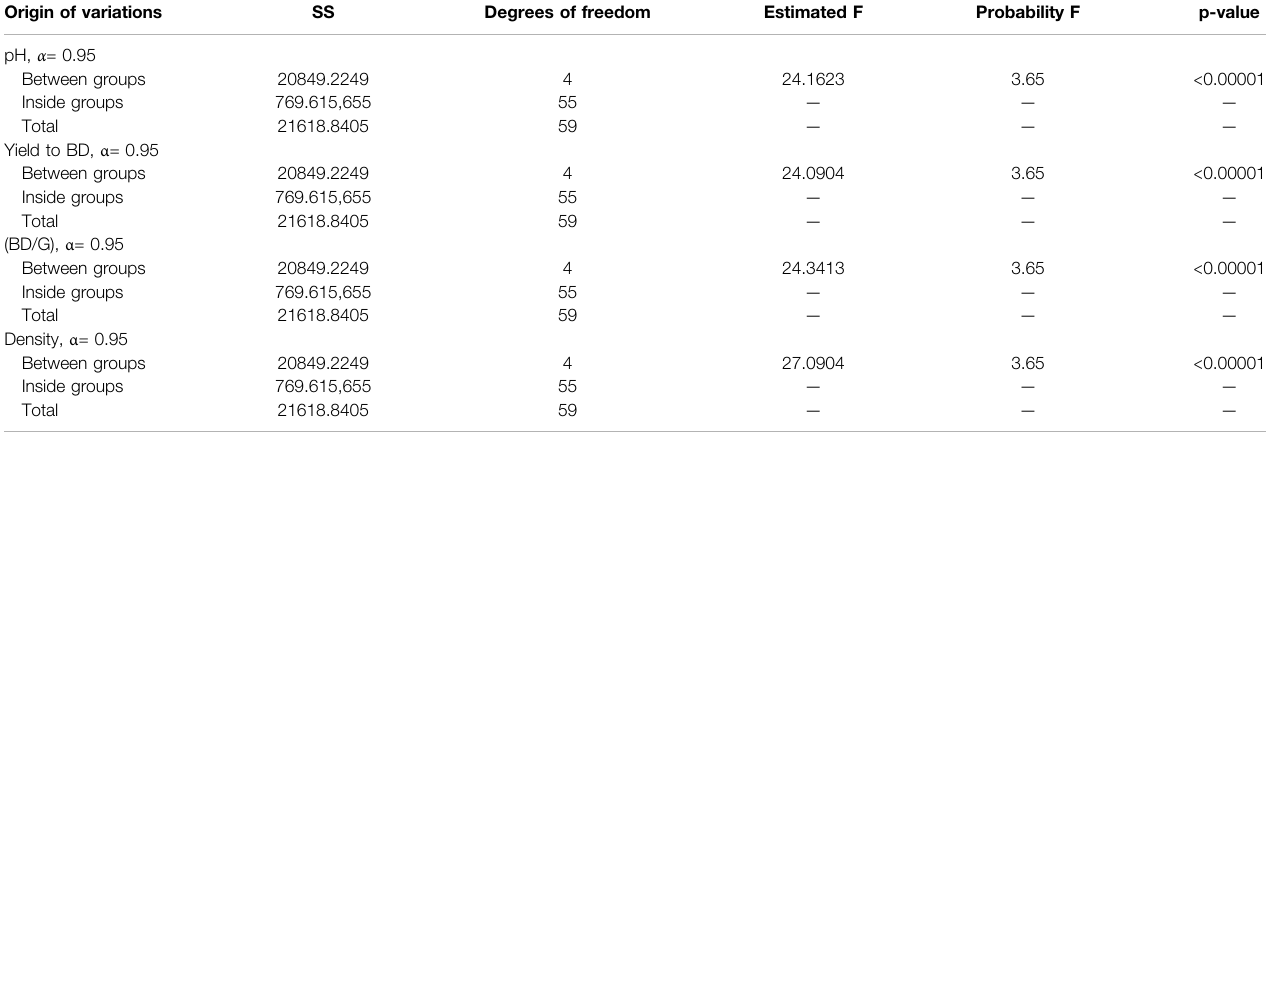
TABLE A2 | ANOVA of results from the 2 4 − 1 design of experiments. Origin of variations SS Degrees of freedom Estimated F Probability F